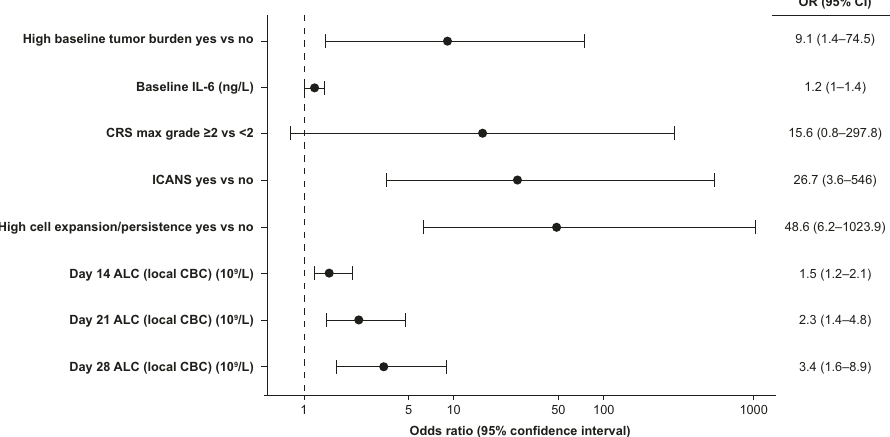
Fig. 4 Forest plot of potential factors associated with MNTs in CARTITUDE-1. ALC absolute lymphocyte count, CBC complete blood count, CRS cytokine release syndrome, ICANS immune effector cell-associated neurotoxicity syndrome, IL interleukin, MNTs movement and neurocognitive treatment-emergent adverse